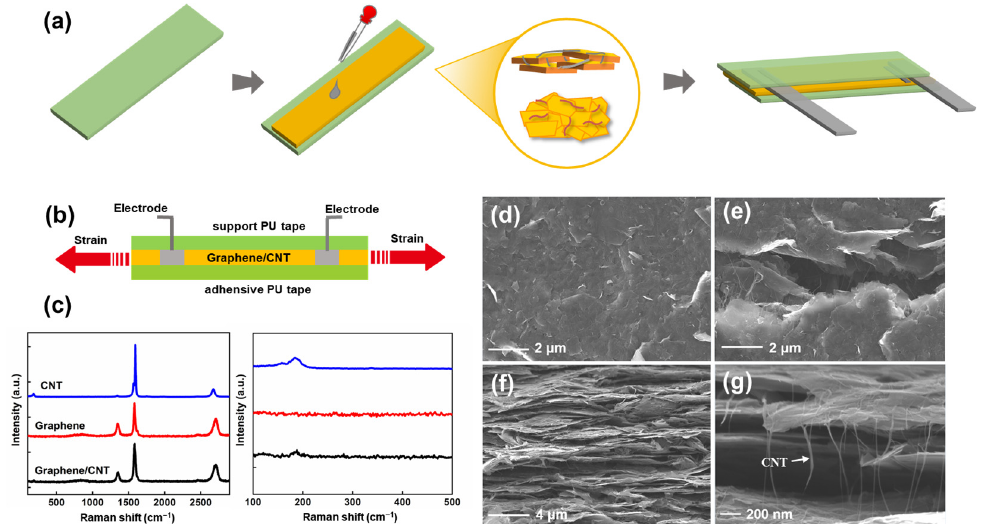
Figure 1. Fabrication and characteristics of the SCG e ‐ skin. ( a ) The fabrication process of SCG e ‐ skin. ( b ) Cross ‐ section illustration of a single SCG e ‐ skin. ( c ) Raman spectra of SWCNT, Graphene, and Graphene/SWCNT, in which the right picture shows the characteristic peak at 100–500 cm − 1 . ( d ) Top ‐ view SEM of the SCG film. ( e ) Top ‐ view SEM of the crack in the SCG film. ( f ) Cross ‐ sectional SEM images of SCG film. ( g ) Cross ‐ sectional SEM images of SCG film with high magnification.